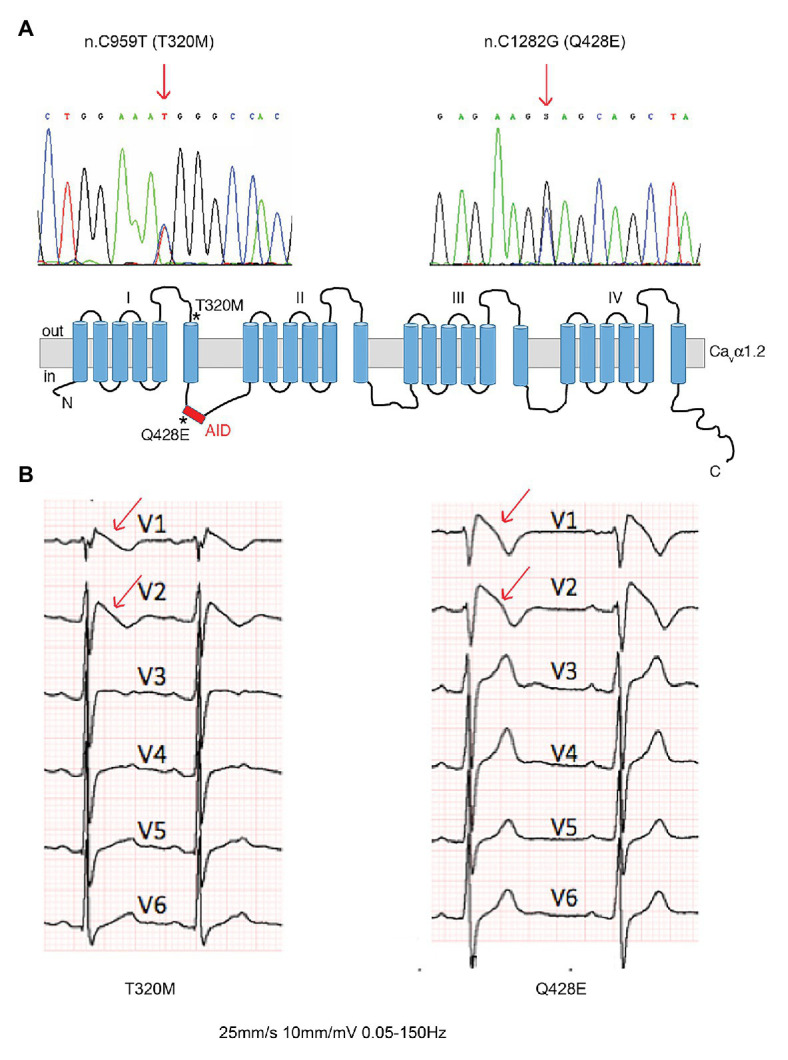
Brugada patients with novel Cavα1.2 loss-of-function (LoF) mutations. (A) DNA sequence analysis showing the two heterozygous single nucleotide substitutions (arrows) in Cavα1.2 responsible for the T320M and Q428E missense mutations, and a schematic representation of Cavα1.2, indicating the location (stars) of mutants. (B) Baseline ECGs showing type 1 coved ST segment elevation pattern (arrows) in the two patients. AID, alpha-interaction domain.